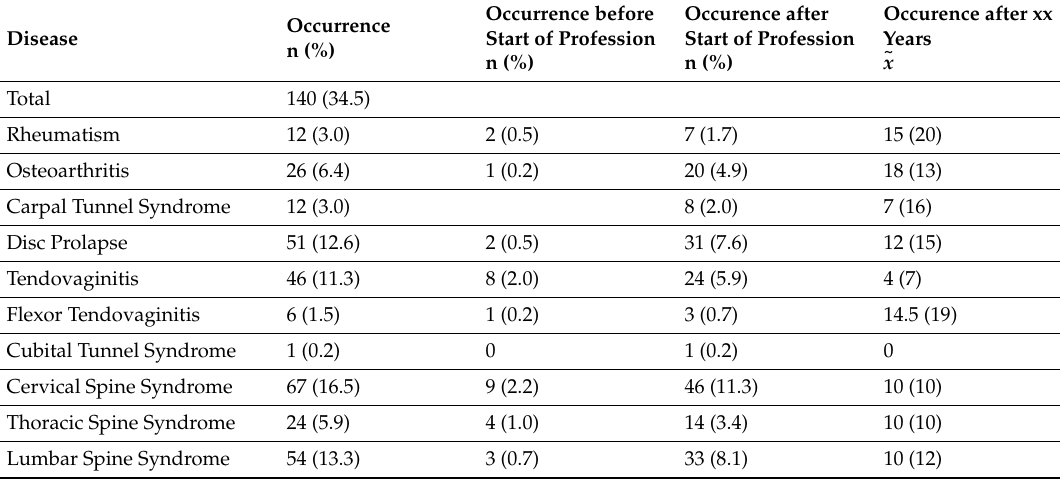
Table 4. Occurrence and start of occurrence of specific medical